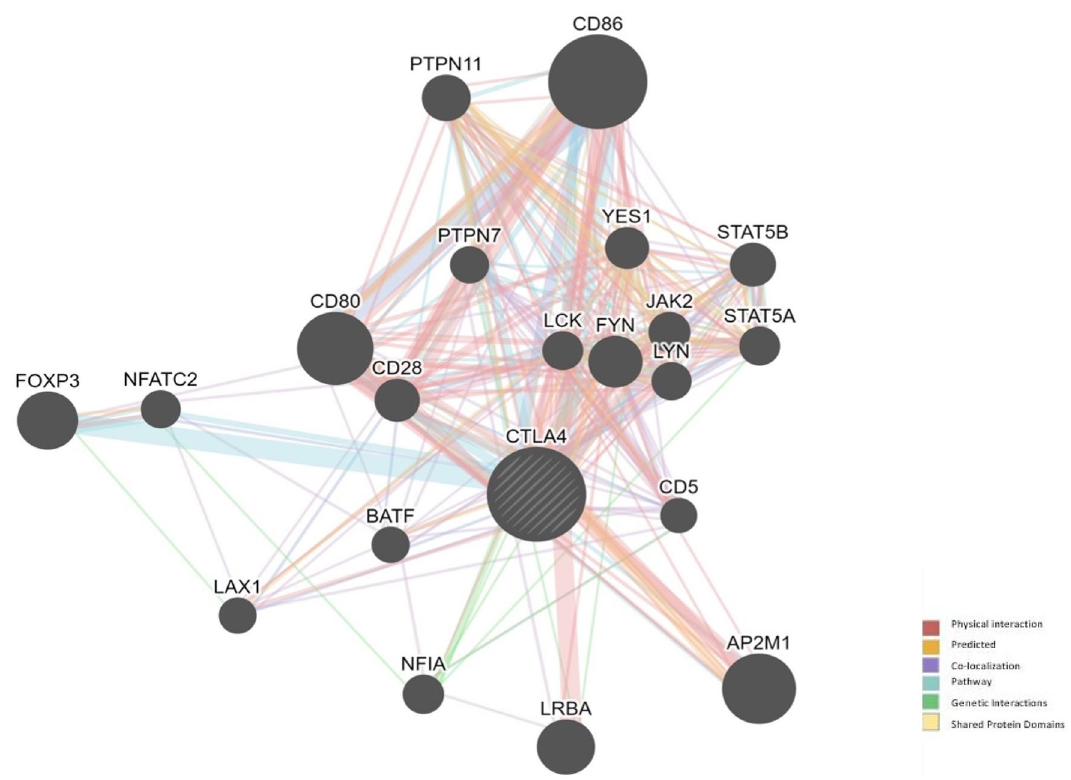
Figure 4. Gene–Gene Interaction of CTLA4 predicted by GeneMANIA. The CTLA4 shows main physical interaction with CD80, CD86, and AP2M1.